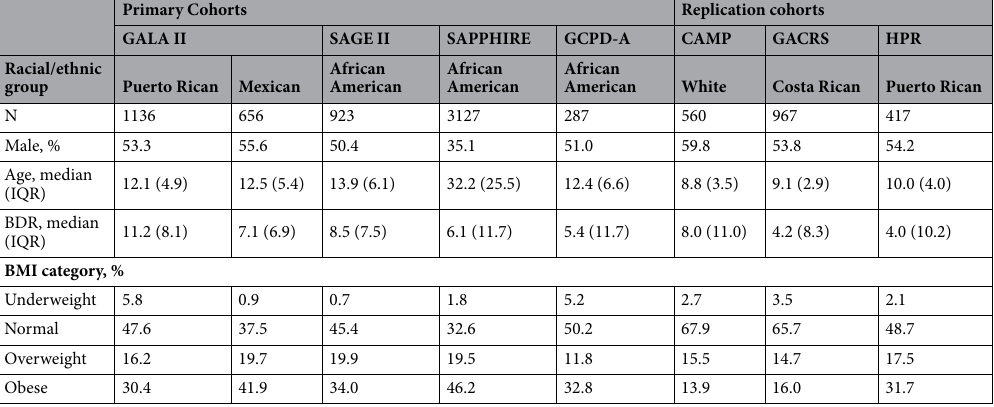
Table 1. Descriptive characteristics of the study subjects. IQR: interquartile range (3rd quantile—1st